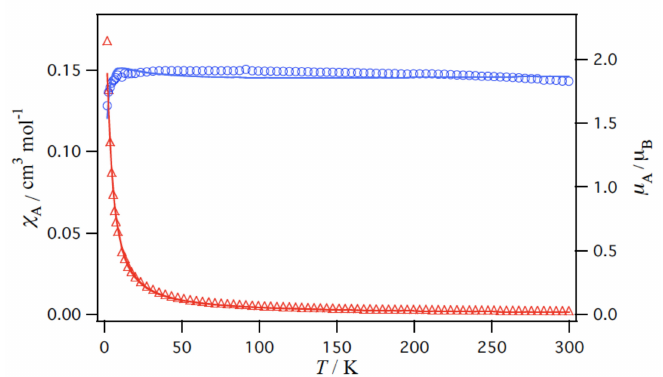
Figure 8. Temperature dependence of magnetic susceptibility χ M ( ∆ ) and magnetic moment µ eff ( ◦ ) of [Cu( L 10 )] ( 10